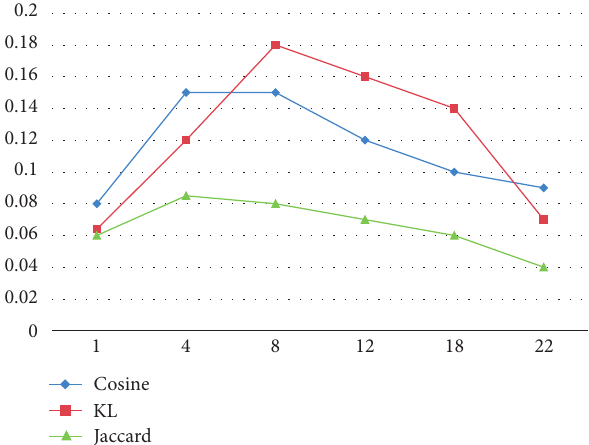
Figure 1: Comparison of three similarity measures under different K values.